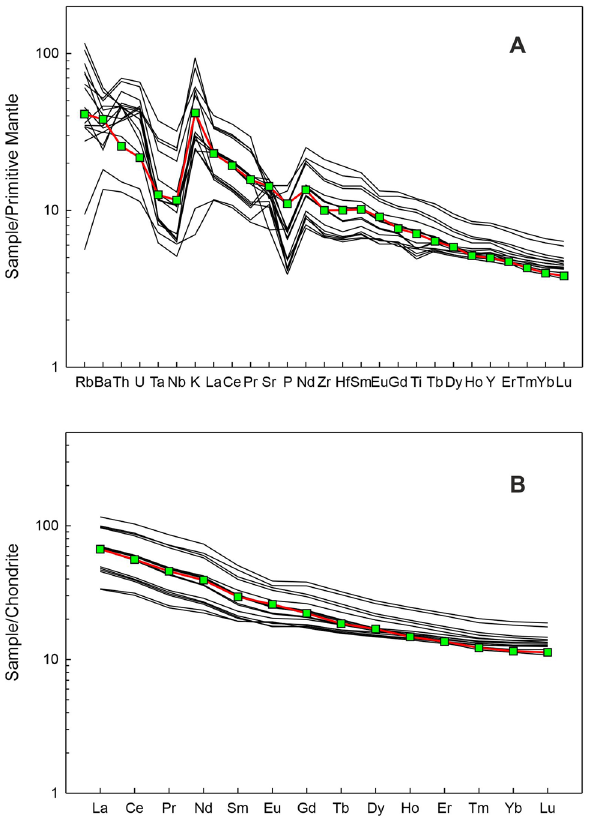
Figure 9. ( A ) Primitive Mantle normalized trace element pattern and ( B ) Chondrite normalized rare earth element pattern for the Chilika Anchor rock (green squares) compared with those for Palitana lava flows (data source: Sheth et al., 2013) 16 . Normalizing values are from Sun and McDonough (1989) 21